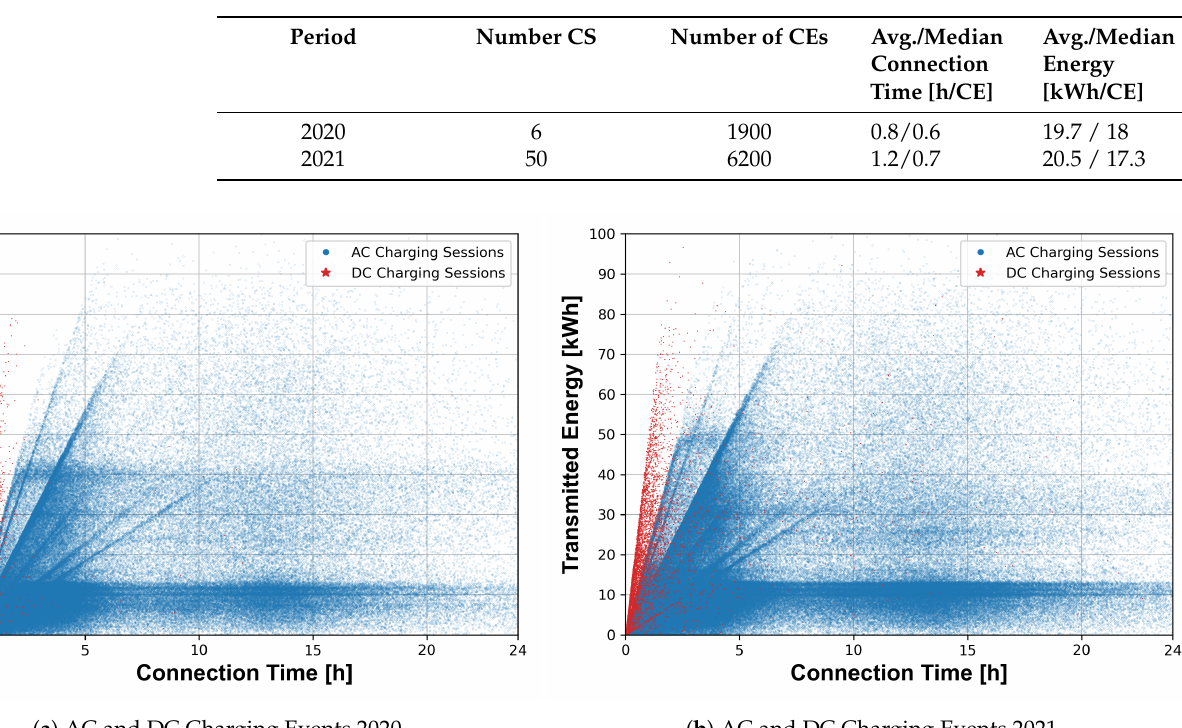
Table 6. KPIs of DC Charging Events from the Real-World Data Set.